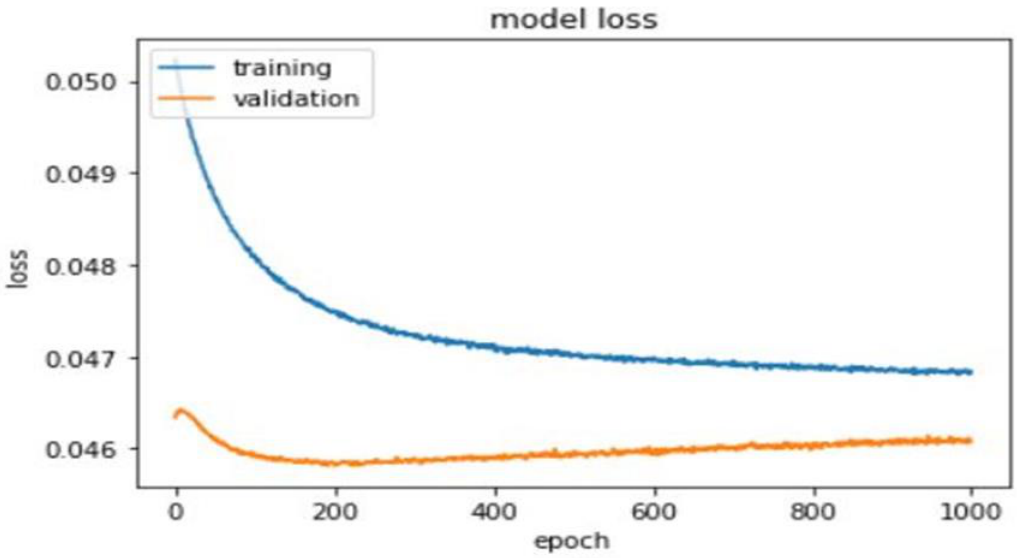
Figure 5. Training and validation loss of the deep learning model.